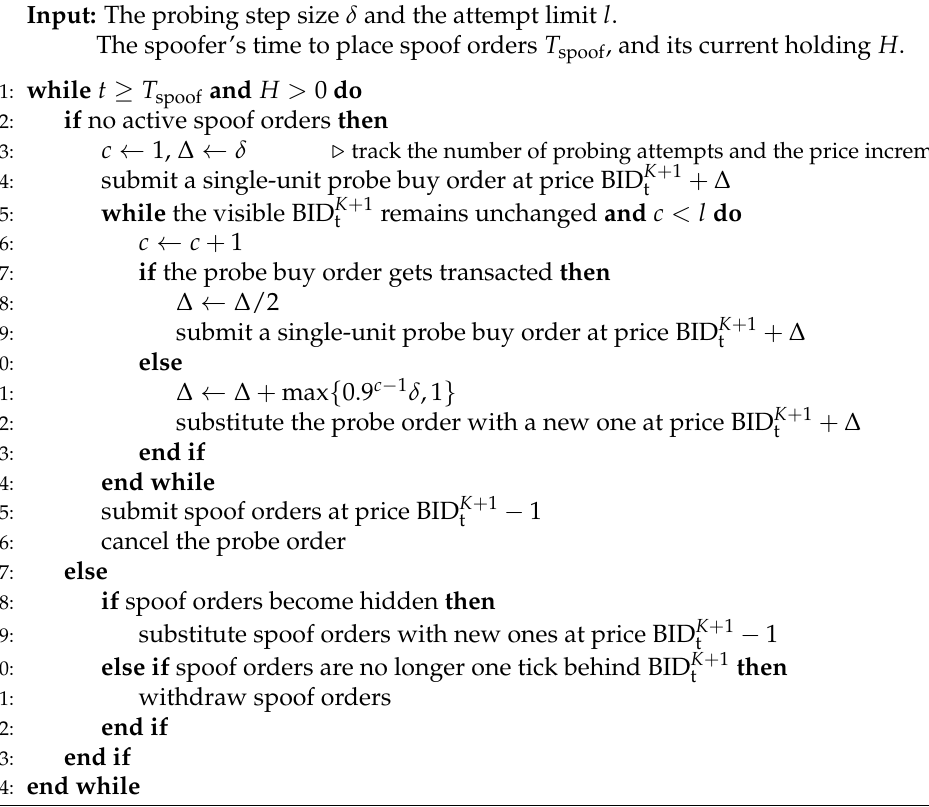
Algorithm 1 Spoofing with probing in a cloaking market with K hidden price levels ( K >